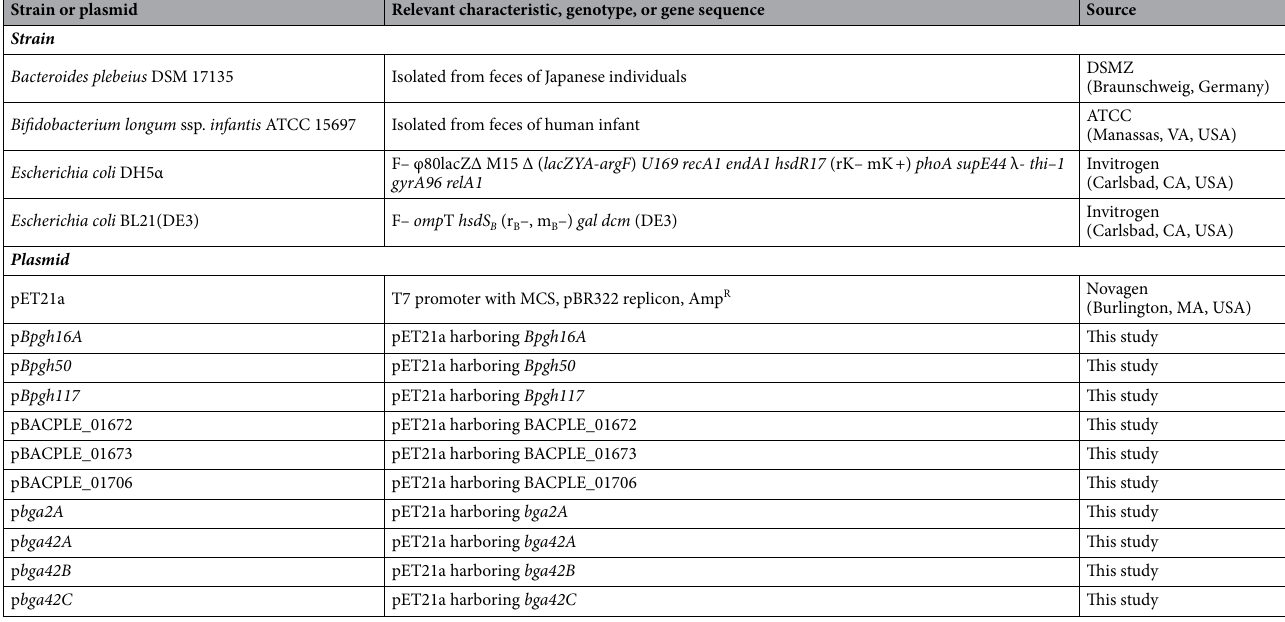
Table 2. Strains and plasmids used in this